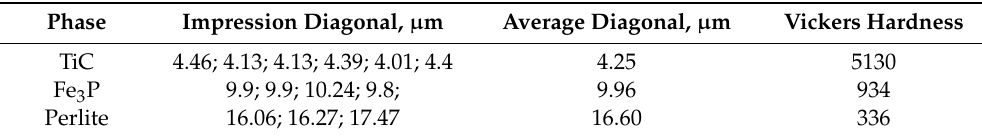
Figure 14. Micrographs of microindentation hardness testing of the pig iron sample obtained ( a – d ) at 1750 ° С (0.49 H, τ = 10 s). Table 7. Microindentation hardness data of pig iron